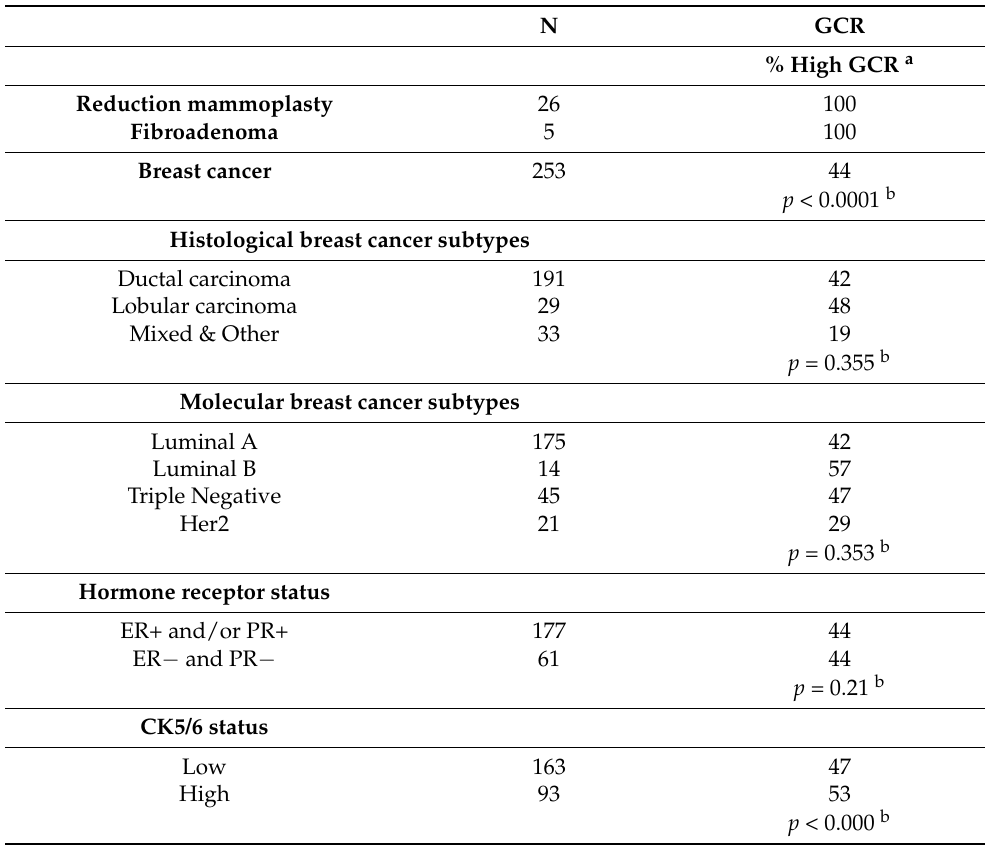
Table 6. GCR expression in breast tissue from the BCCC TMA